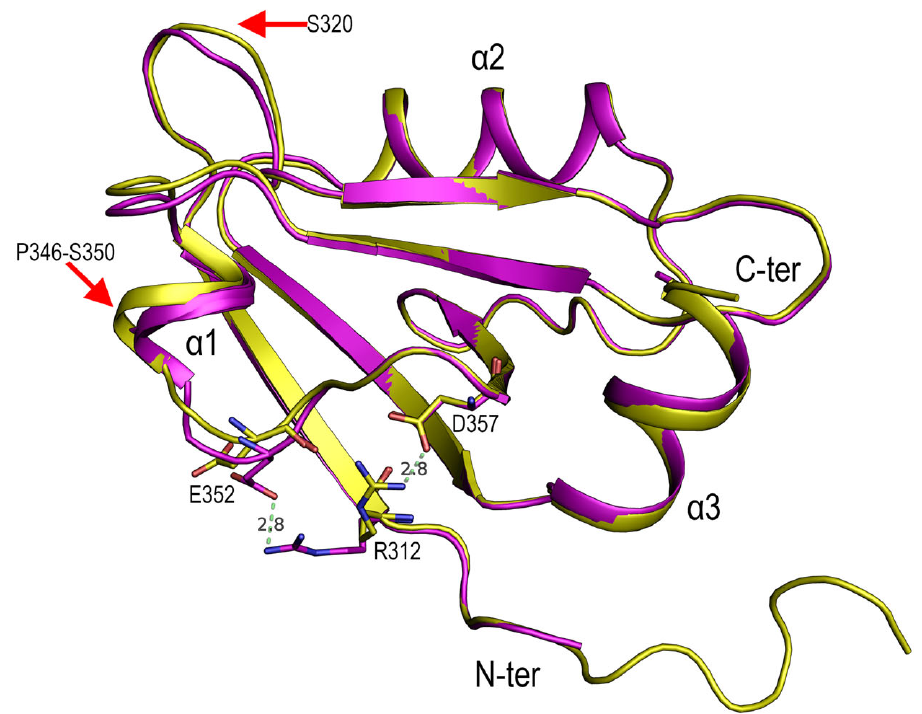
Figure 4. Comparison of the Asp357 electrostatic interactions in the orthorhombic-B (yellow) and the trigonal structures (magenta). The sidechains of the interacting residues are represented by sticks. For clarity, only chain A of the trigonal polymorph has been represented. Distances between Arg312 and Asp357 or Glu352 are marked in dashed lines (green). Red arrows indicate the most prominent differences between the orthorhombic and trigonal polymorphs: α 1, residues 346–350, and the β -turn next to the canonical binding site GLGF, comprising residues 322–325.